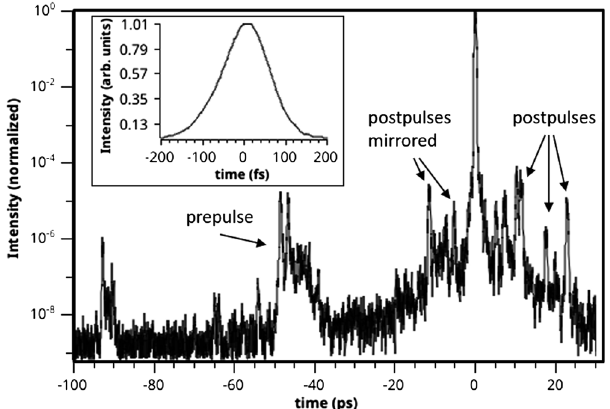
FIG. 5. Laser contrast and pulse duration. The laser contrast base level was measured by a cross-correlator and is better than 10 − 8 . This suppresses the laser intensity below the ionization threshold of Si until the prepulse at − 50 ps. The main laser pulse temporal shape is shown in the inset by the autocorrelation